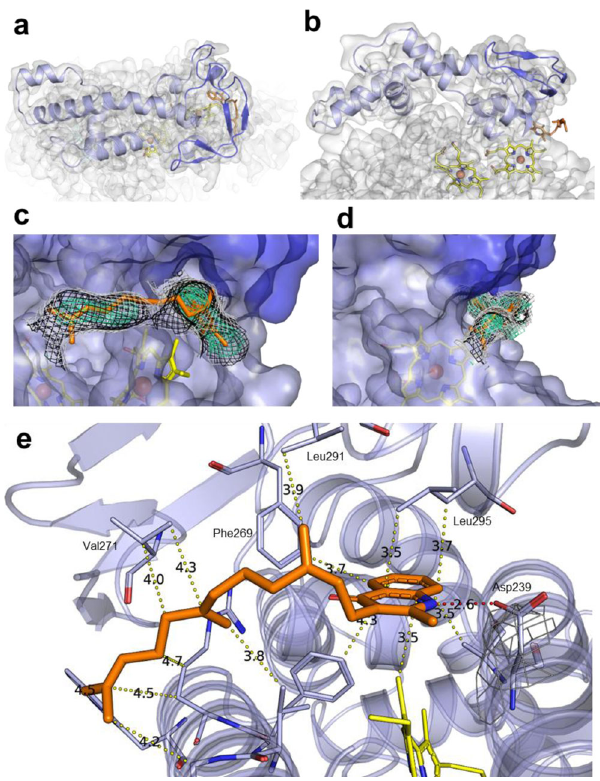
Fig. 3 Structure of the Q-loop and binding of aurachin D. a Top view and b side view of the entire Q-loop (blue) of bd -II on top of subunit AppC (gray) with the previously unresolved region in dark blue. The additional density, interpreted as aurachin D is shown in orange. c , d Surface view on the quinol binding site with the Q-loop in blue, the TM part of AppC in light blue, heme b 558 in yellow and bound aurachin D in orange. The experimental Coulomb density map is shown as different meshes in green cyan (at 1.0 σ ), black (at 0.65 σ ), and white (at 0.5 σ ), all carved at 2 Å radius around model atom centers. The view on the binding site is turned by 90° from ( c ) to ( d ). e Hydrophobic interactions and the H-bond of aurachin D with bd -II are indicated by dotted lines and are labeled with